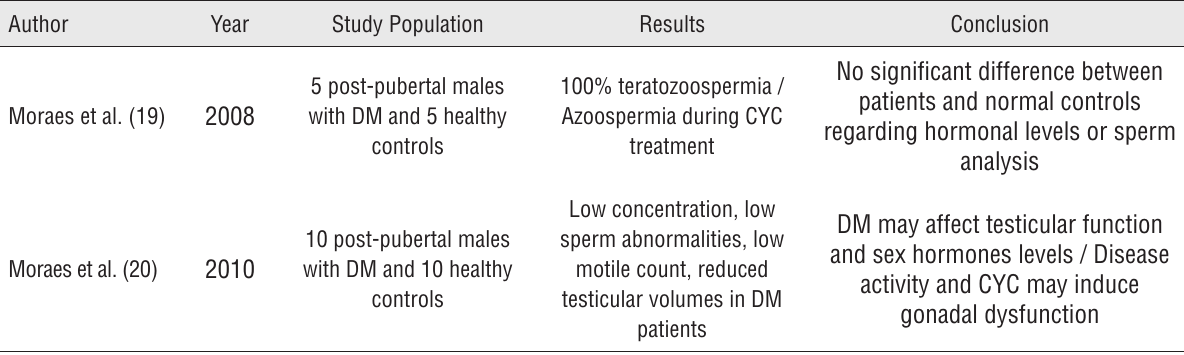
Table 2 – Dermatomyositis and male